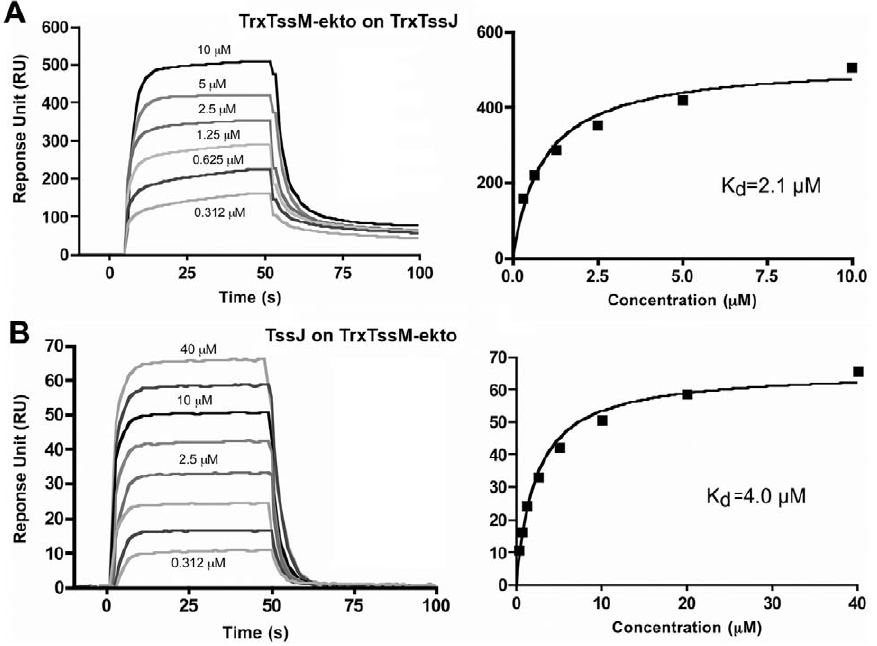
Figure 3. Measure of the interaction between TssM-ekto and TssJ by Surface Plasmon Resonance. ( A ) Sensorgram and saturation curve of the titration of Trx-TssJ by Trx-TssM-ekto. The CM5 chip (BIAcore) was coated with TssJ N-terminal thioredoxine fusion with 600 response units (RU) and the Trx-TssM-ekto was injected in the microfluidic channel. ( B ) Sensorgram and saturation curve of the titration of Trx-TssM-ekto by TssJ. The CM5 chip was coated with TssM-ekto N-terminal thioredoxine fusion with 3000 response units, and TssJ was injected in the microfluidic channel. The K D values were obtained using the fitting tool of the BIAevaluation software (BIAcore).